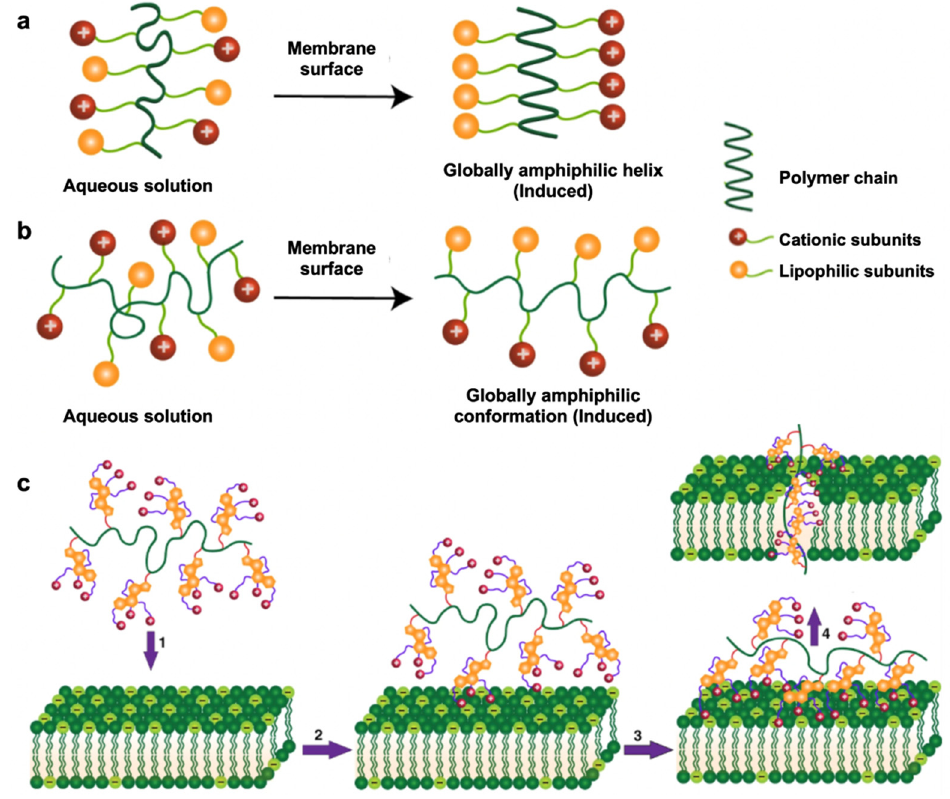
Figure 3. Modes of action upon contact with bacterial membrane surfaces. ( a ) Global amphiphilic helical conformation adopted by host-defense peptides; ( b ) global amphiphilic random conformation adopted by synthetic antimicrobial polymers. ( c ) Proposed antibacterial mechanism of synthetic antimicrobial polymers: (1) diffusion, (2) surface binding via cationic subunits, (3) membrane insertion via lipophilic subunits and (4) membrane disruption. (Adapted from Rahman et al., [104] 2018 with modifications.)